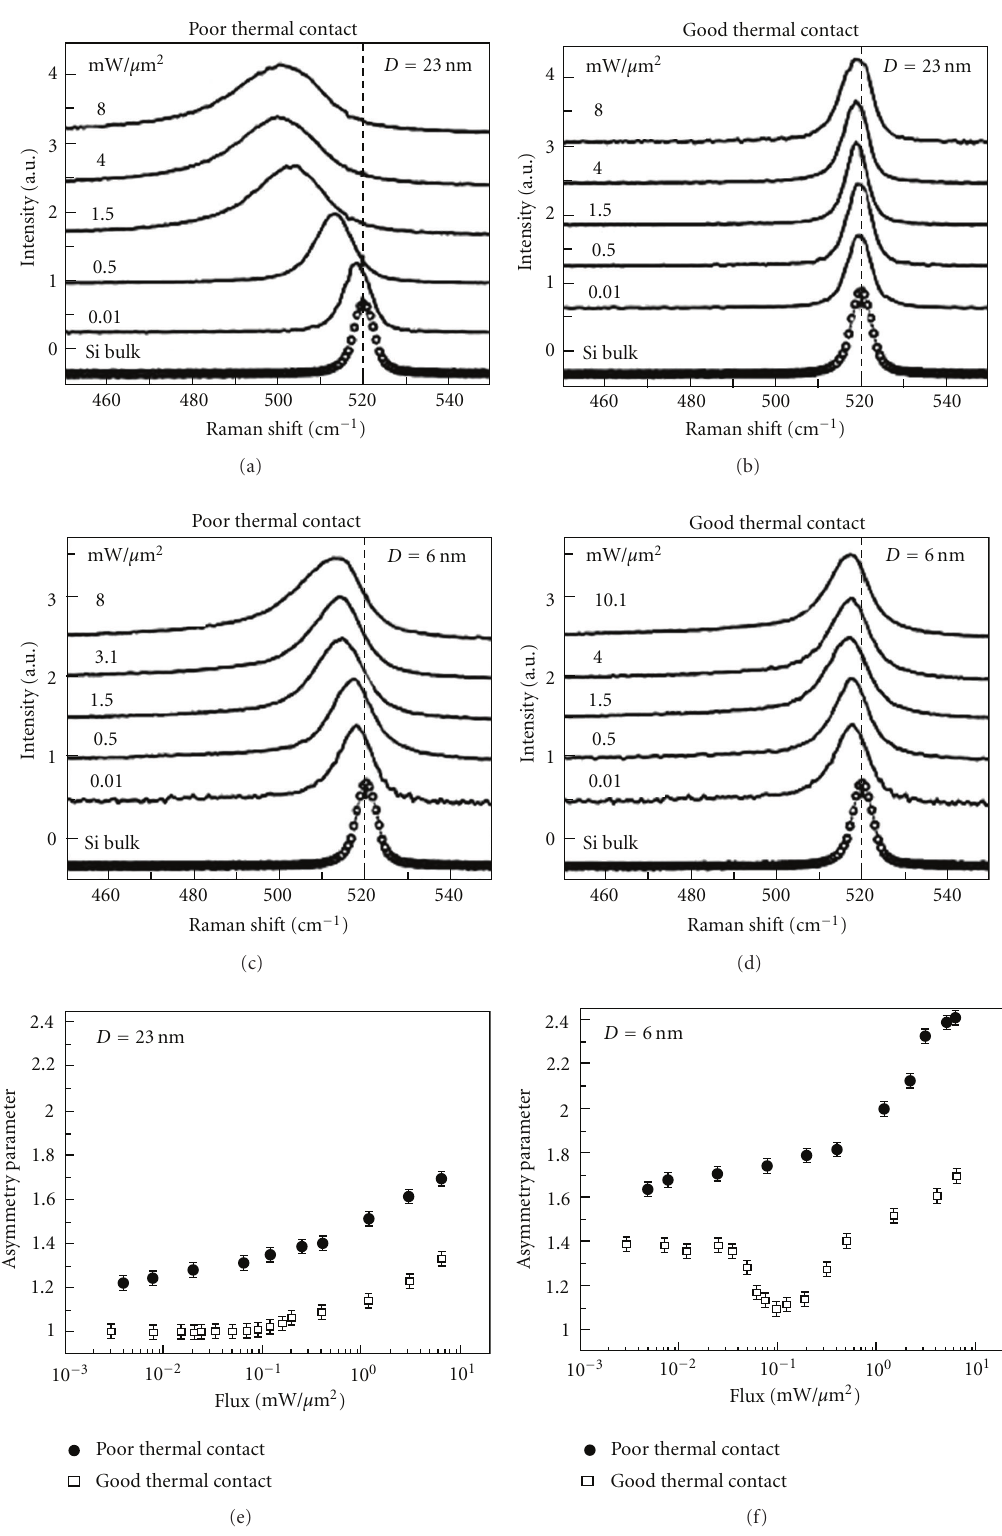
Figure 10: Flux ( Φ ) dependent Raman spectra of Si nanowires collected under poor thermal anchorage (a, c) and good thermal anchorage (b, d) for 23 nm wires (a, b) and 6.0 nm wire (c, d). The nanowires were located on an Indium substrate. (b) Flux ( Φ ) dependence of the asymmetry parameter A for Si nanowires under poor thermal contact (solid circles) and good thermal contact (open squares) for (e) 23 nm (f) 6.0nm Si nanowires